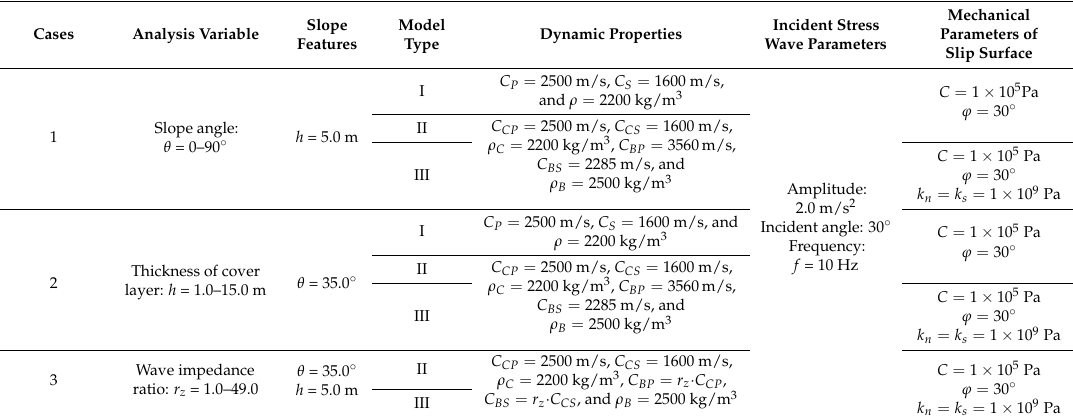
Table 2. The variables and parameters of slope features effect analysis (P- and